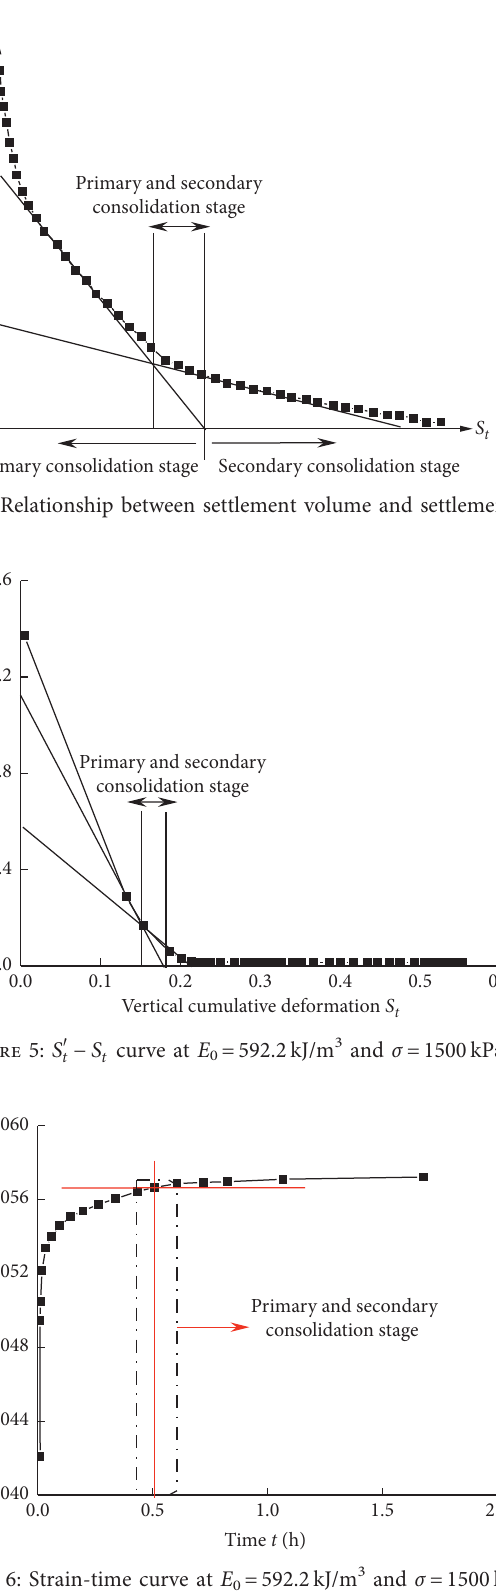
� 592.2kJ/m 3 and σ � 0